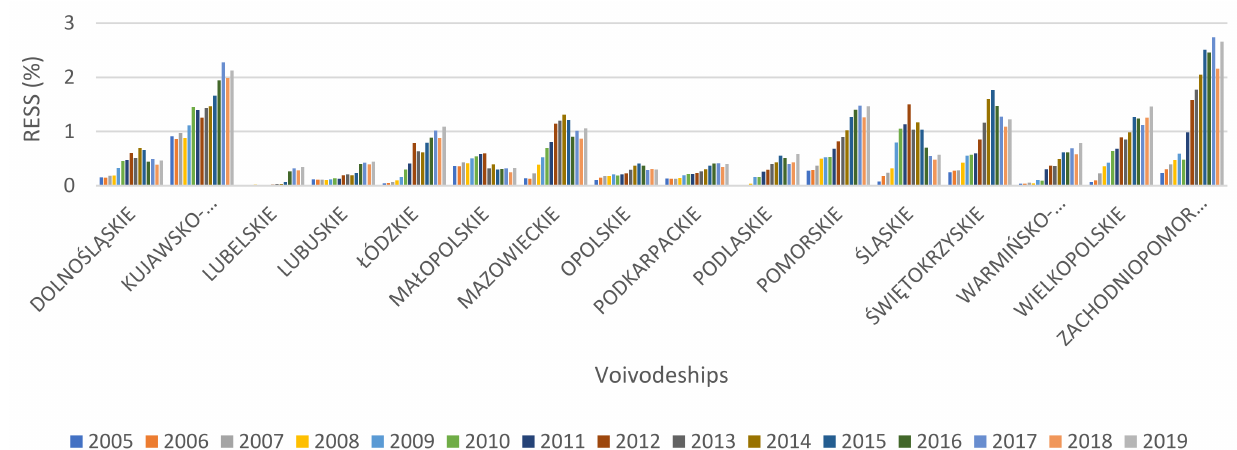
Figure A7. RES production share in individual voivodeships in total electricity consumption in Poland (RESS) in 2005–2019 (%). Source: Own calculations based on the LDB.